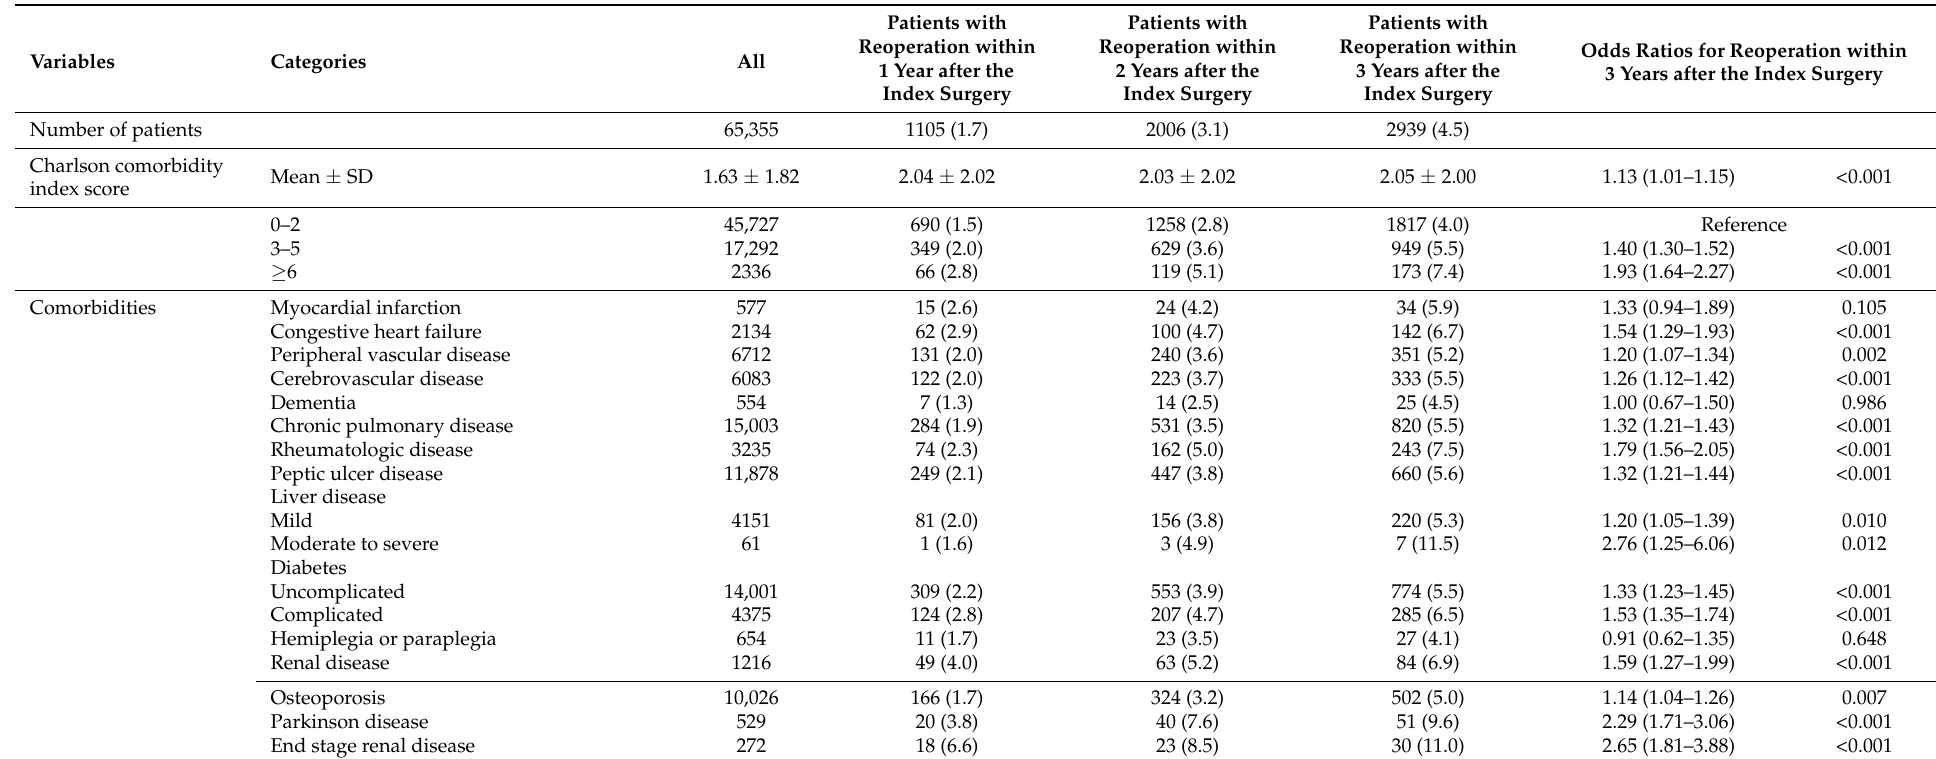
Table 3. Annual reoperation rates according to